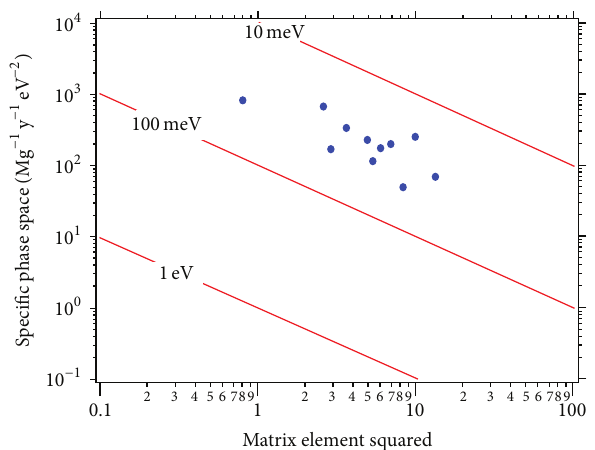
Figure 4: Specific phase space versus the geometric mean of the squared NME’s reported in Table 2, for (in increasing order of abscissa) 48 Ca, 150 Nd, 136 Xe, 96 Zr, 116 Cd, 124 Sn, 130 Te, 82 Se, 76 Ge, 100 Mo, and 110 Pd. Phase space factors are evaluated at 𝑔